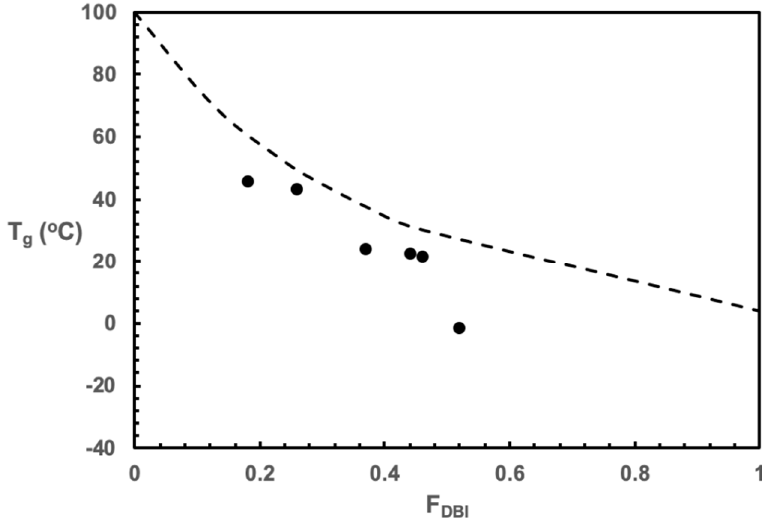
Figure 10. F DBI effects on T g in P(DBI-S) statistical copolymers. The Fox equation prediction of the P(DBI-S) T g are represented by the dotted line while the experimental data is presented by the solid circles.